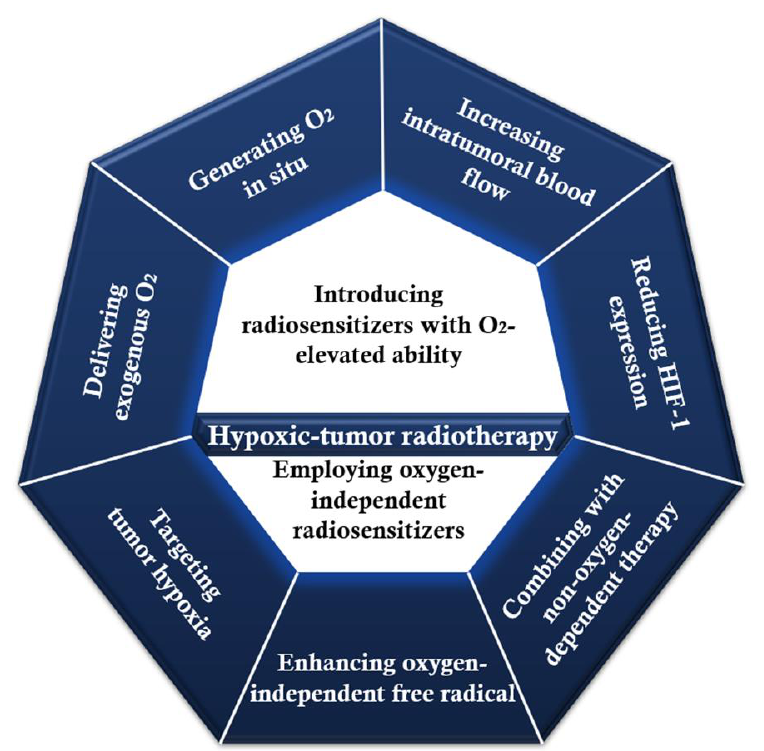
Figure 11. Potential strategies employing metal-based NPs for hypoxic-tumor radiotherapy. Created based on information from [170].